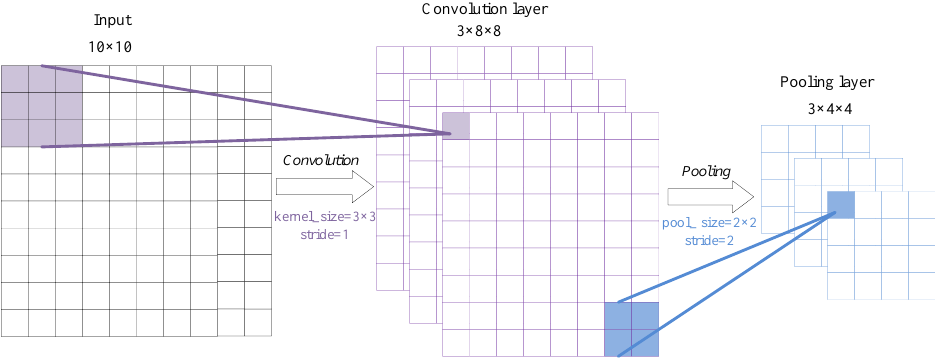
Figure 2. The sub-convolution-pooling neural network.